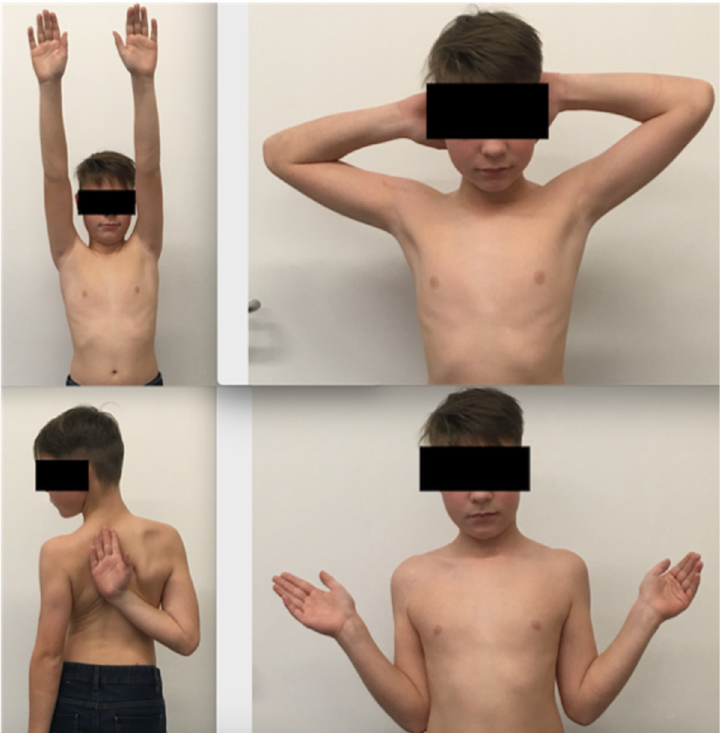
Figure 5. Range of motion after plate fixation of a proximal humerus fracture on the right site (Patient N° 6).